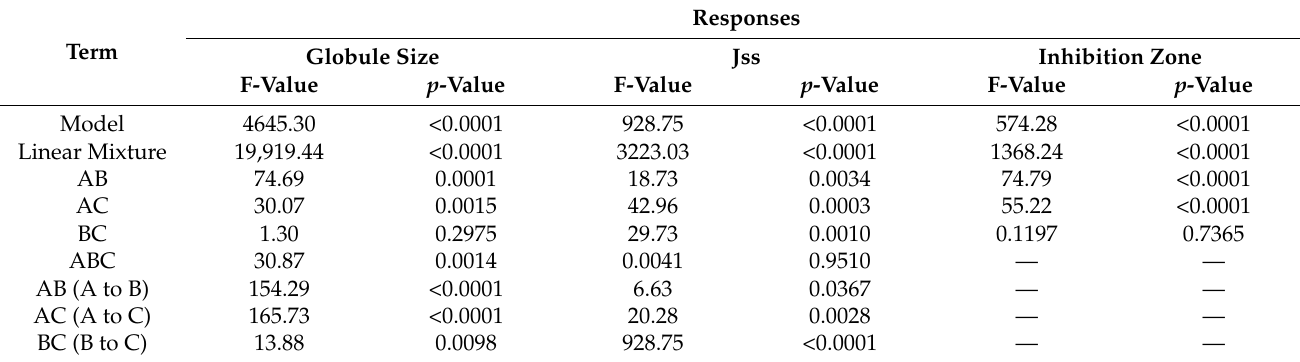
Table 7. ANOVA results in three